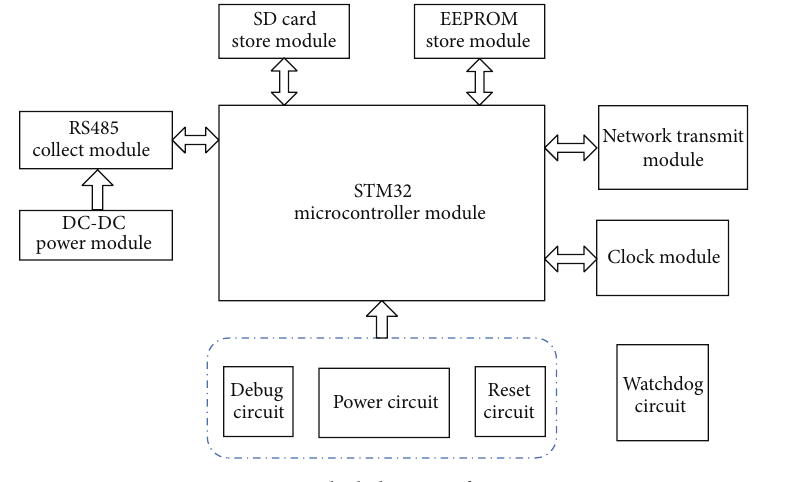
Figure 1: Block diagram of system.